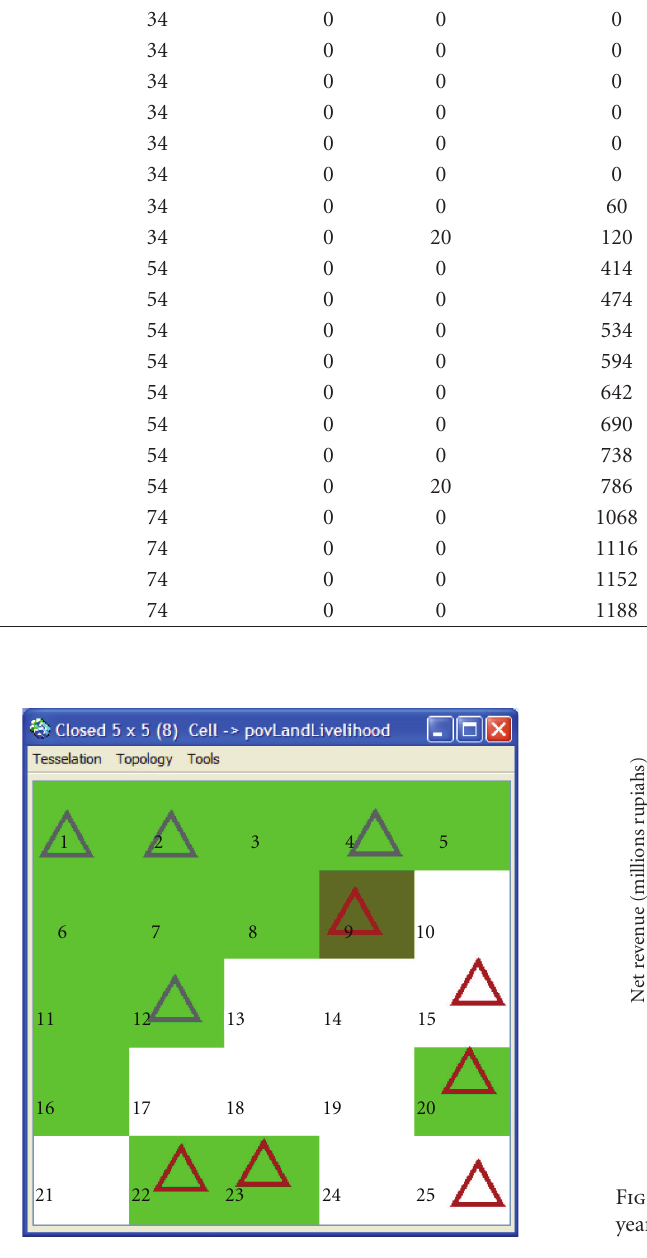
Figure 7: Scenario C1: six players invest in rubber plantation (cell 9), and the other three players invest in MHR (cells 20, 22, and 23).